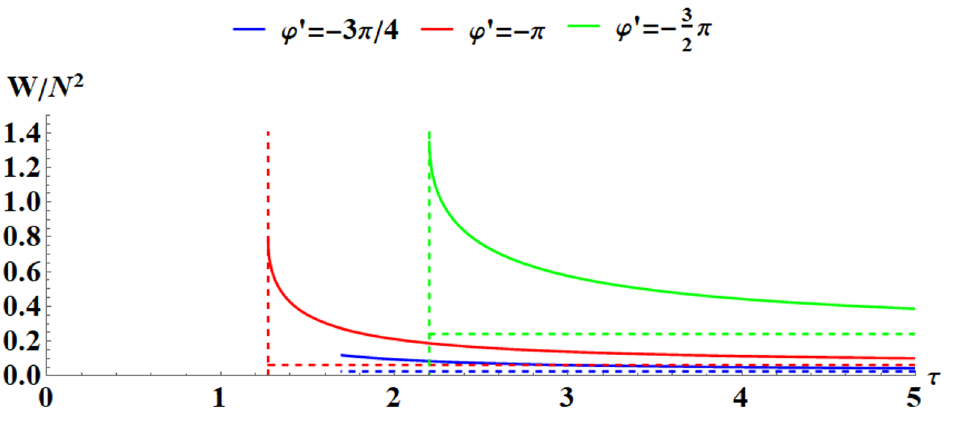
= 0 with ϕ 0 = − 3 Figure 15 . W vs. τ when Ω 0 π , − π and − 3 π (upper to lower respectively). b 2 4 There are only “small” black holes: they all have W > 0 and negative specific heat. For any given ϕ 0 , there is a minimal BPS temperature which corresponds to the maximal BPS free